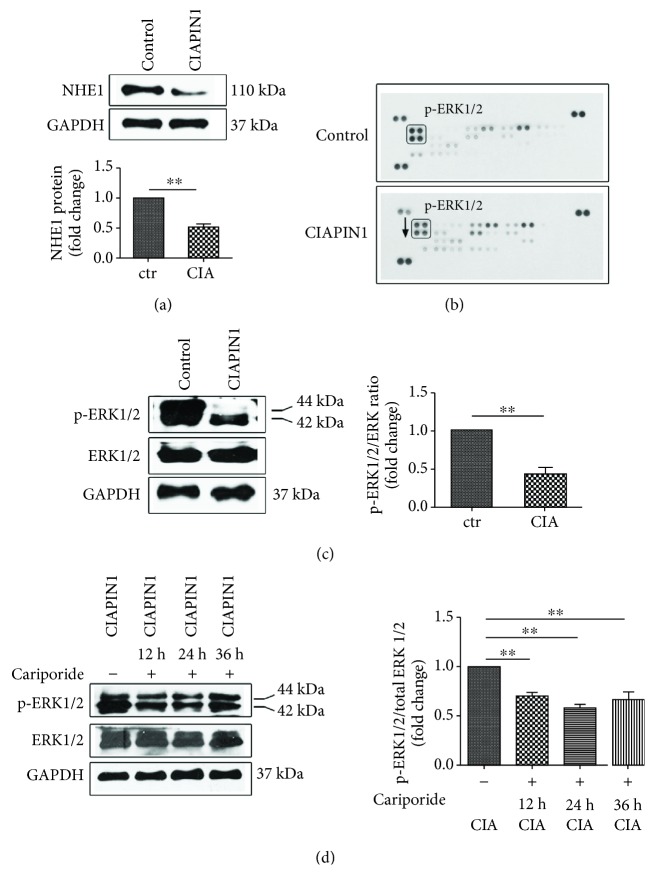
NHE1 and ERK1/2 signaling pathway might contribute to cells' metastatic potential conferred by CIAPIN1 upregulation. (a) The NHE1 protein expression was decreased in A549 cells with CIAPIN1 upregulation. (b, c) The protein array and western blotting were conducted to detect the ERK1/2 signaling pathway changes in A549 cells with CIAPIN1 upregulation. (d) ERK1/2 phosphorylation was further modulated by the NHE1 inhibitor at the indicated time in A549 cells with CIAPIN1 overexpression. Each value indicated the mean ± SD of three independent experiments. ∗∗P < 0.01, compared with control.